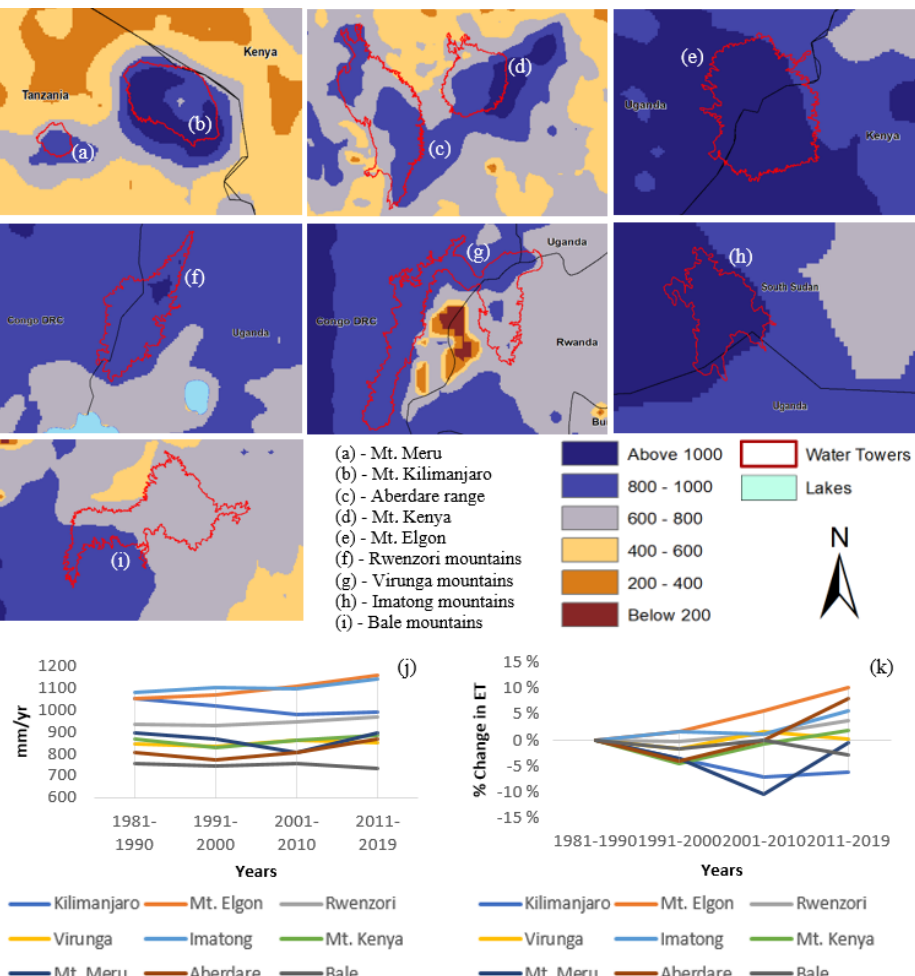
Figure 5. Distribution of long-term actual evapotranspiration. The spatial distribution of long-term ET in and around the water towers (a–i) and the changes in the different water towers (j, k) are